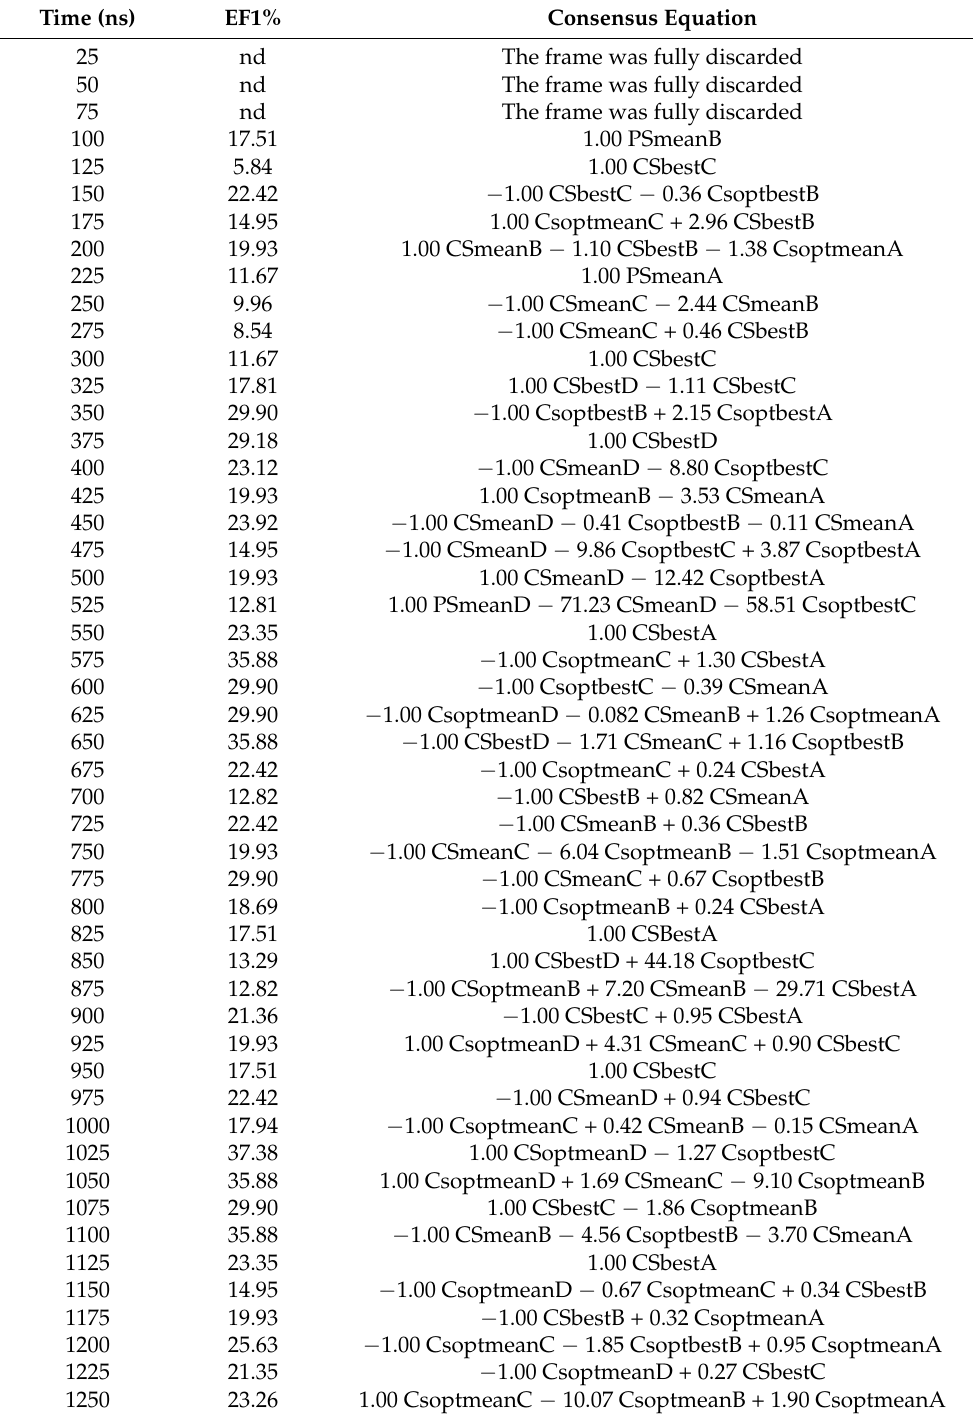
Table 1. Best predictive consensus models and relative EF1% values as obtained by the non- optimized